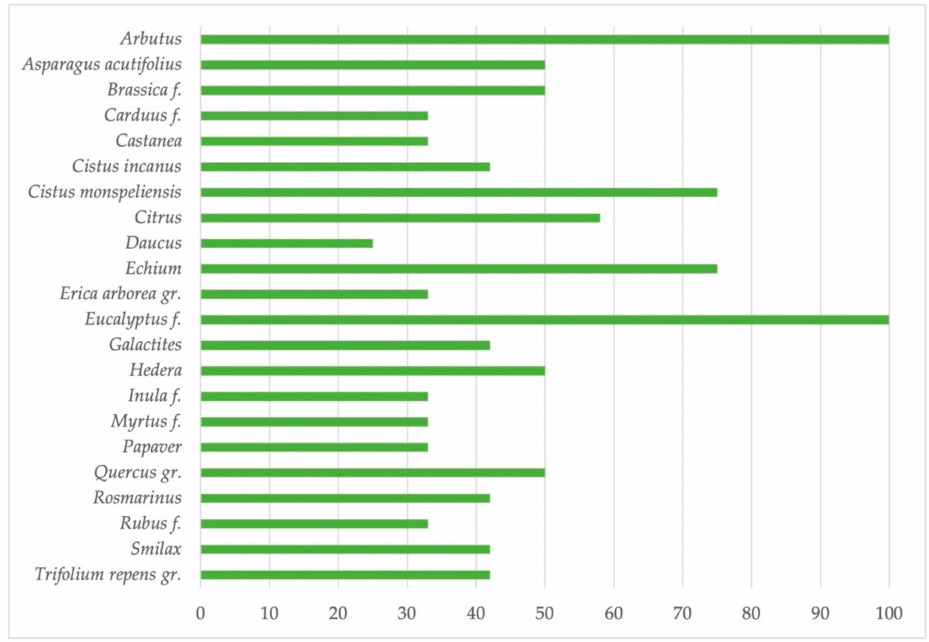
Figure 4. The most frequent pollens recorded in Sardinian bitter honey samples (expressed as % of honey samples)